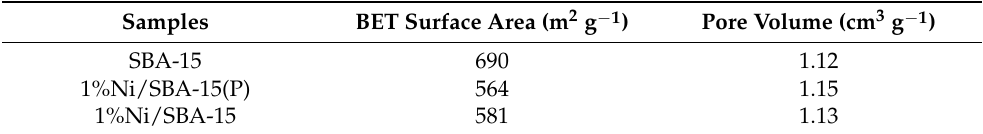
Figure 1. ( a ) N 2 adsorption-desorption isotherms and ( b ) pore size distributions of SBA-15, 1%Ni/SBA-15, and 1%Ni/SBA-15(P). Table 1. Physicochemical properties of catalysts. Samples